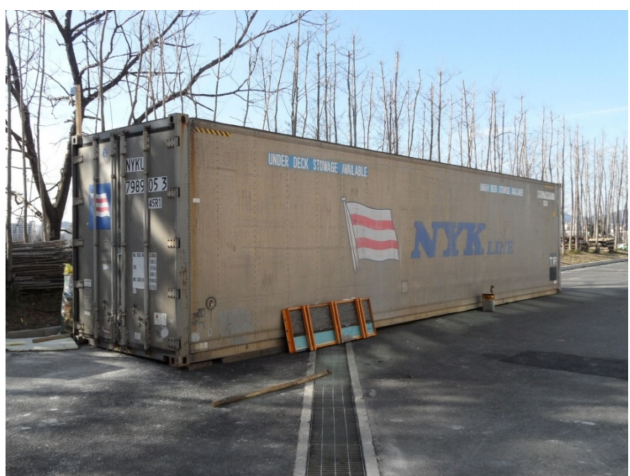
Figure 2. View of the refrigerated